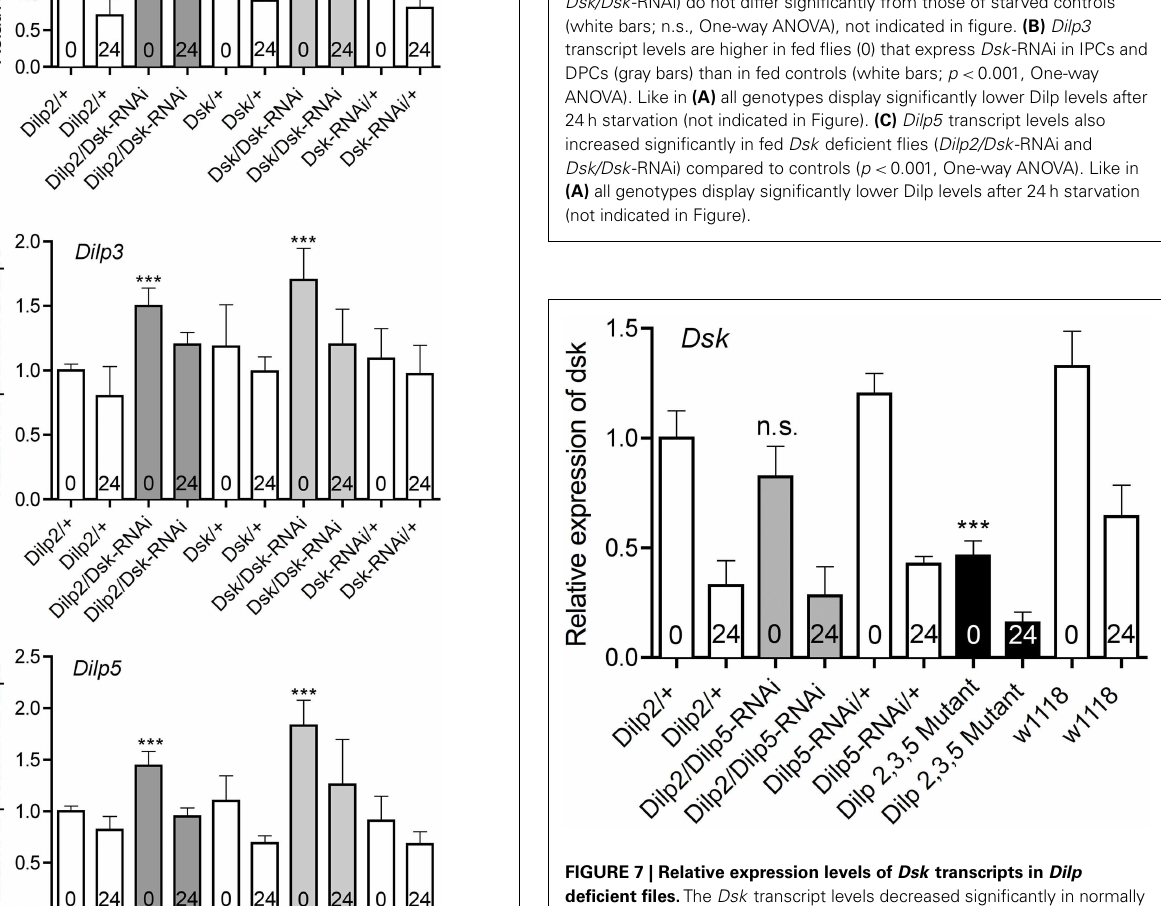
regulation of peptide gene transcription in these